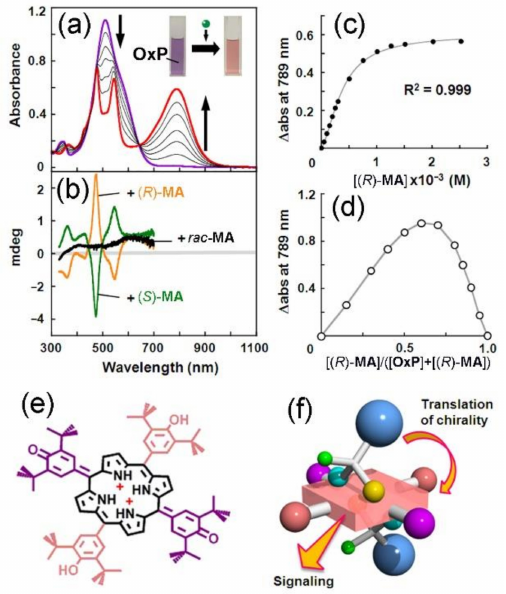
Figure 3. ( a ) Variation in UV-vis spectrum during titration of OxP (10 − 5 M, CH 2 Cl 2 ) with ( R ) - MA. ( b ) CD spectra of OxP (10 − 5 M, CH 2 Cl 2 ) in the presence of respective excesses of ( R ) - , ( S ) - or ( rac ) - MA . ( c ) Change of absorbance at 789 nm with ( R ) - MA concentration. ( d ) Job’s plot of interaction of OxP with ( R ) - MA . ( e ) Chemical structure of diprotonated tautomer of OxP . ( f ) Illustration of the concept of transfer of chiral information from MA to the NMR output of the achiral OxPH 2 2+ host. Adapted with permission from Ref. [42]. Copyright 2009 American Chemical